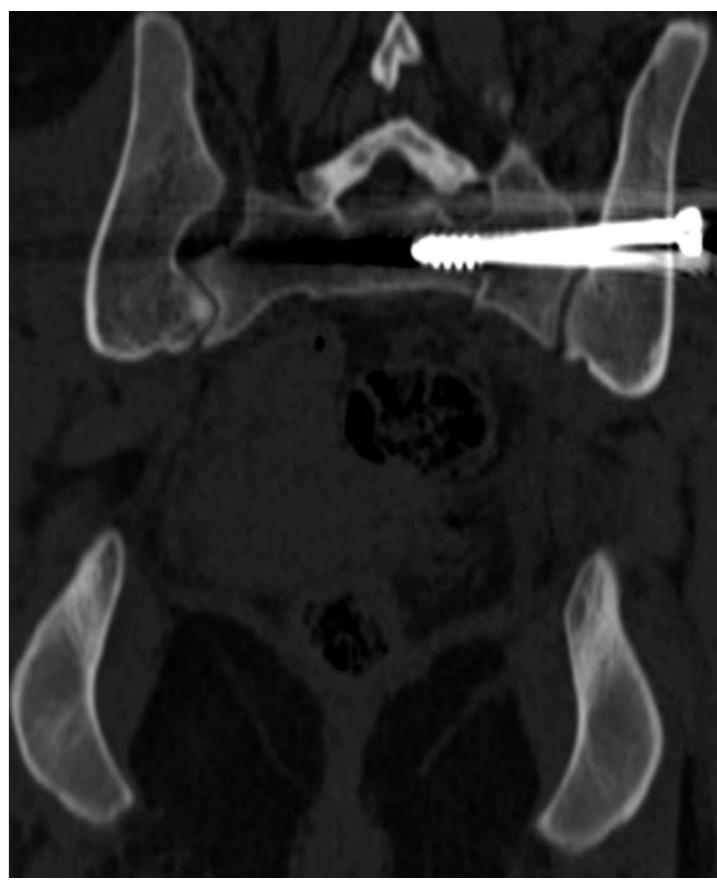
Figure 1. Screw inside the sacrum (Smith type 0).